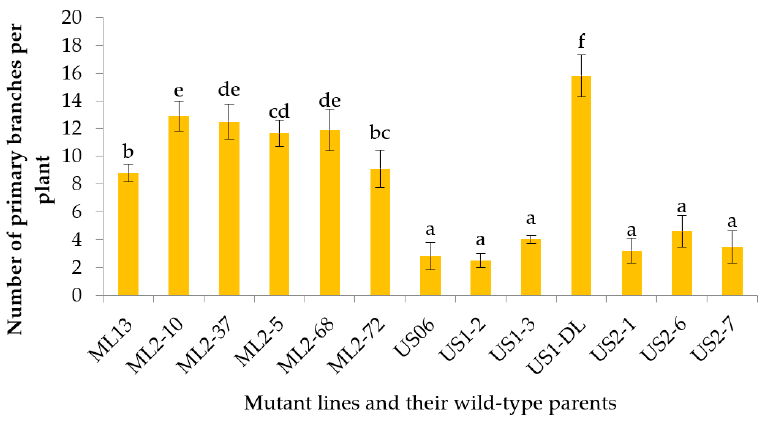
Figure 6. Number of primary branches per plant (NBP) in 11 sesame mutant lines and their two wildtypes (US06 and ML13). The superscript letters represent the groups according to Duncan’s